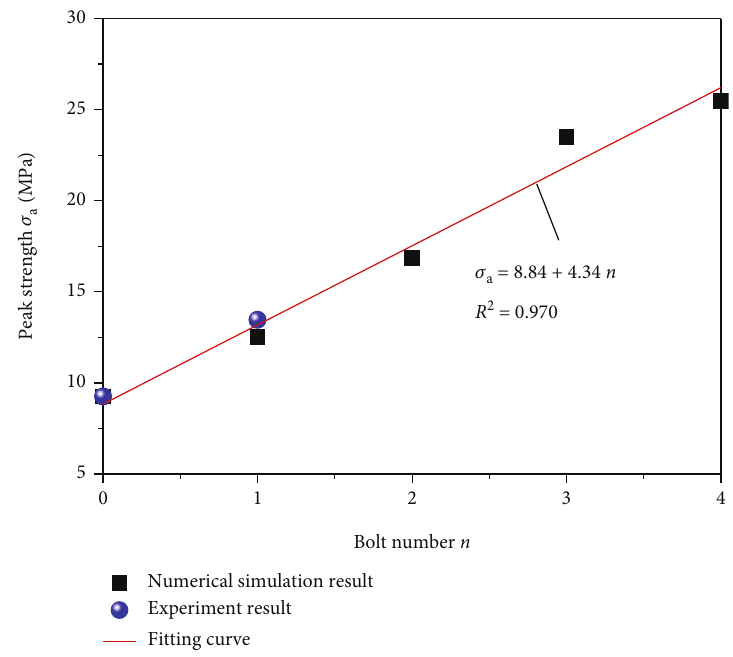
Figure 7: Relationship between peak strength and bolt number of rock mass specimen.